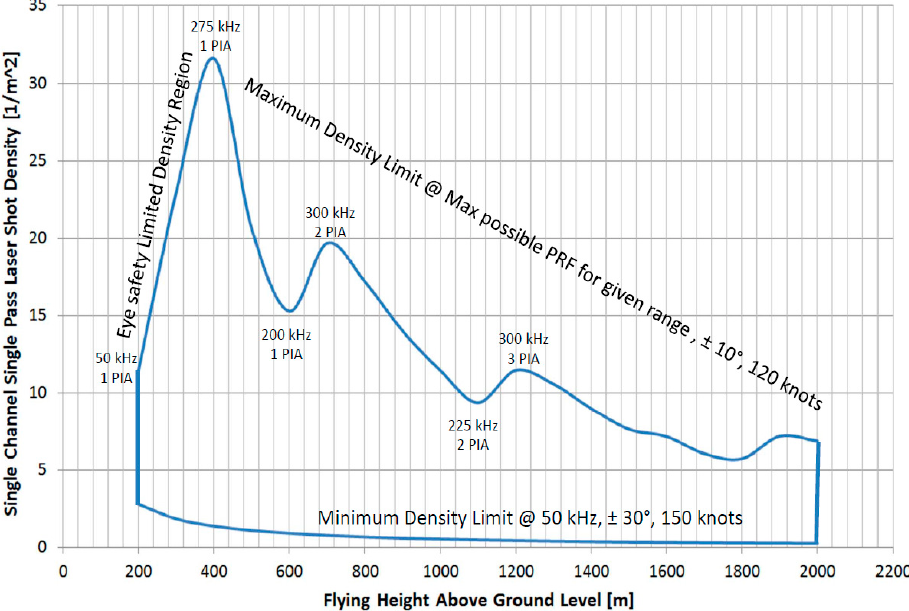
Figure 3. Laser shot density envelope for a single pass and single channel of the Titan sensor.